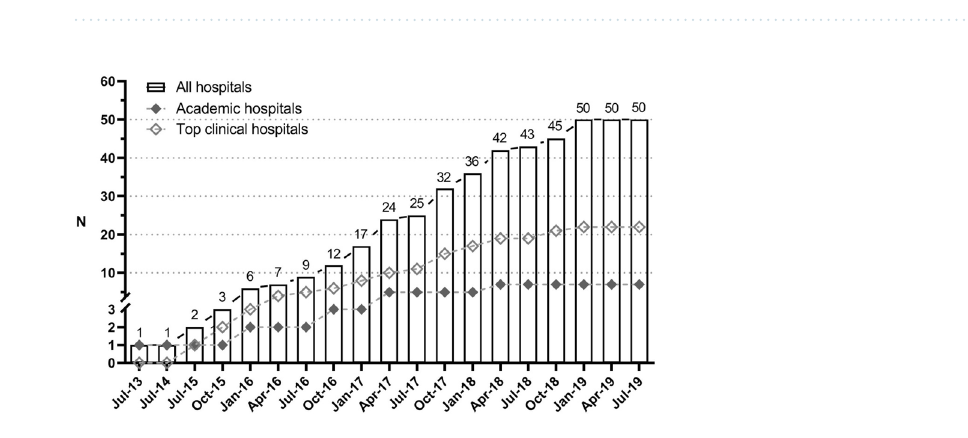
Figure 1. Flow diagram of the selection of individuals for the current analyses. a Insufficient data in patient’s EHRs for the NCR to collect a complete TNM stage. b Missing due to time-lag in NCR clinical data collection. This number is higher than presented in Table 1, as for some cases sufficient staging information was available to classify into TNM stage.